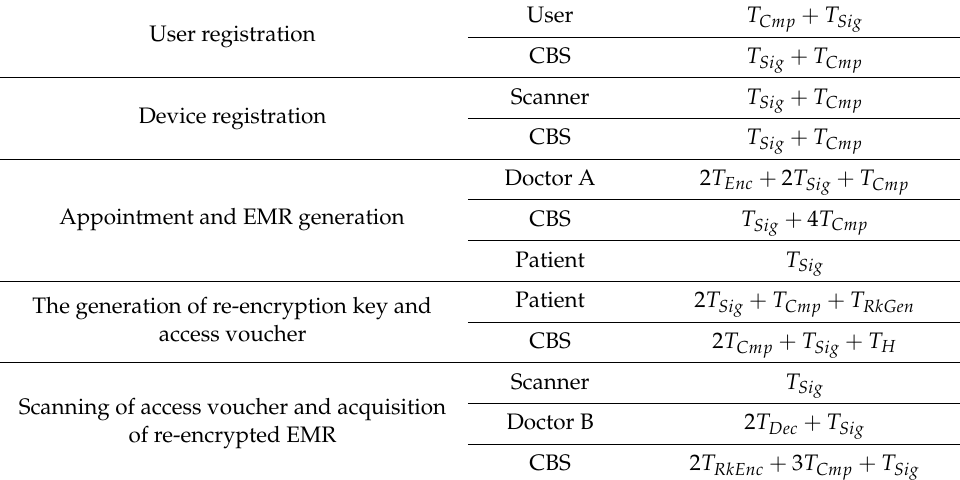
Table 7. The computation cost of the proposed scheme.